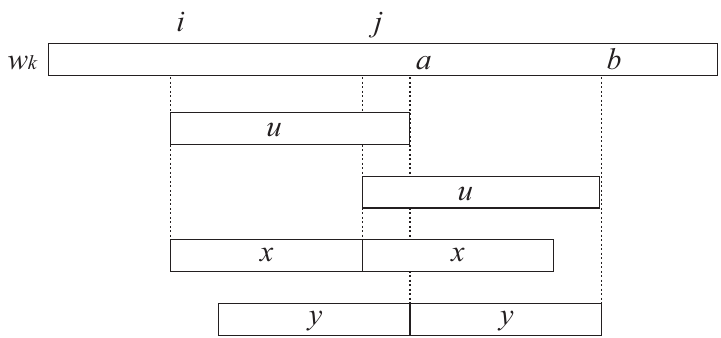
Figure 2. Illustration for proof of Lemma 2. Since u is represented by a node